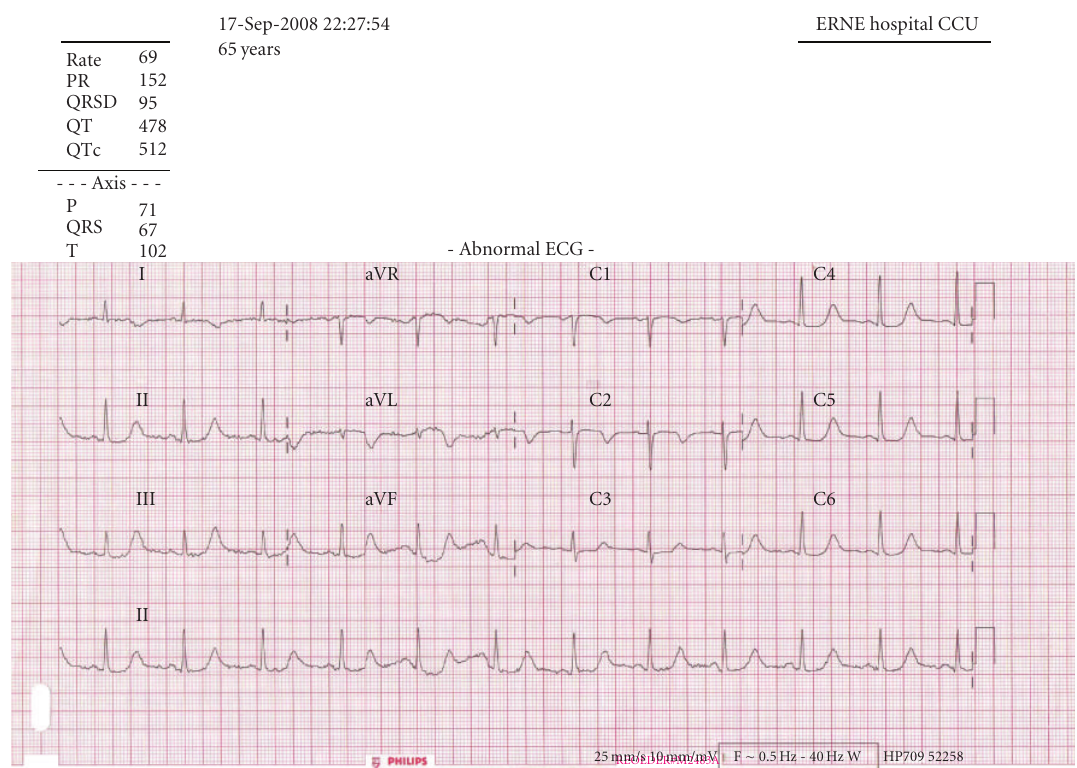
Figure 1: 12-lead ECG displaying the patient’s prolonged QT interval (QTc 512